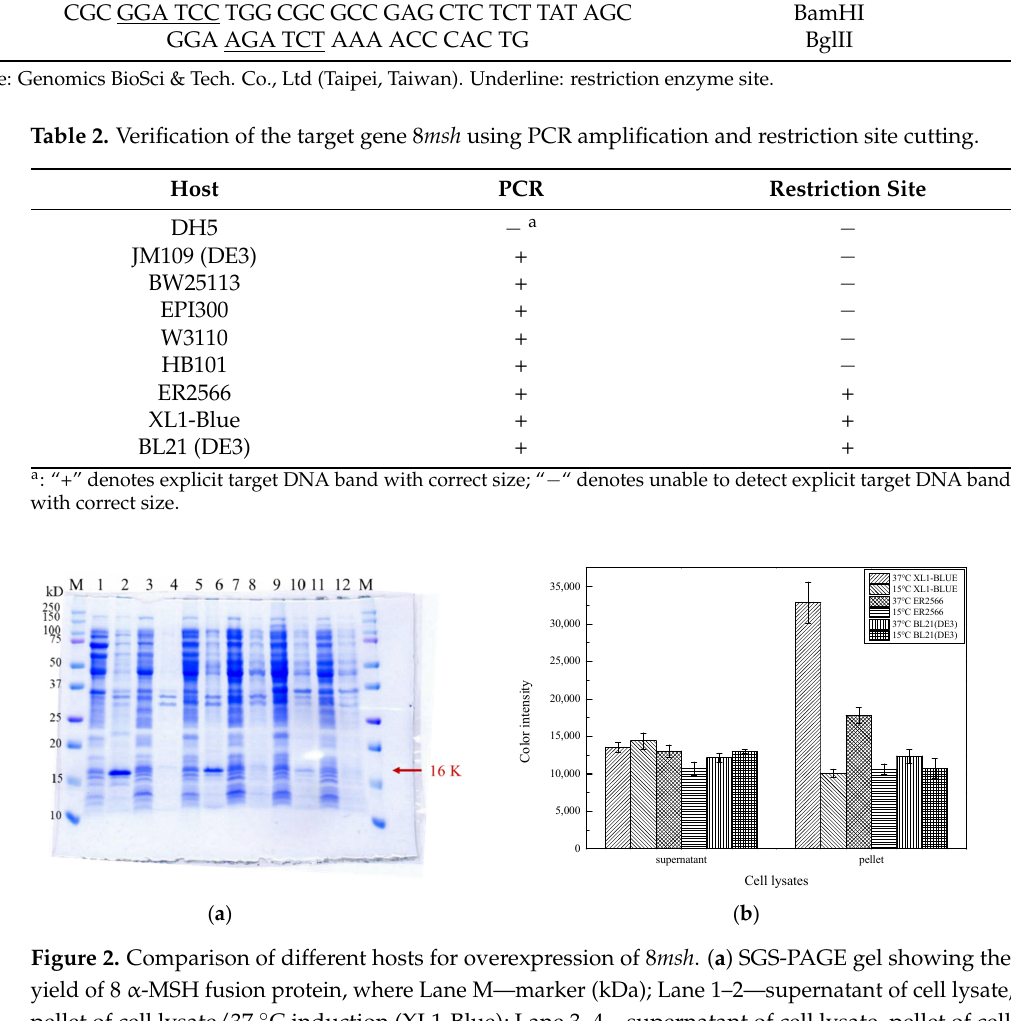
Figure 3. Dissolving 8 α -MSH inclusion body using urea solution (2–6M). Lane M—marker (kDa); Lane 1–3—original cell lysate, supernatant of cell lysate, pellet of cell lysate; Lane 4–6—2 M urea cell lysate mixture, supernatant of cell lysate, pellet of cell lysate; Lane 7–9—4 M urea cell lysate mixture, supernatant of cell lysate, pellet of cell lysate; Lane 10–12—6 M urea cell lysate mixture, supernatant